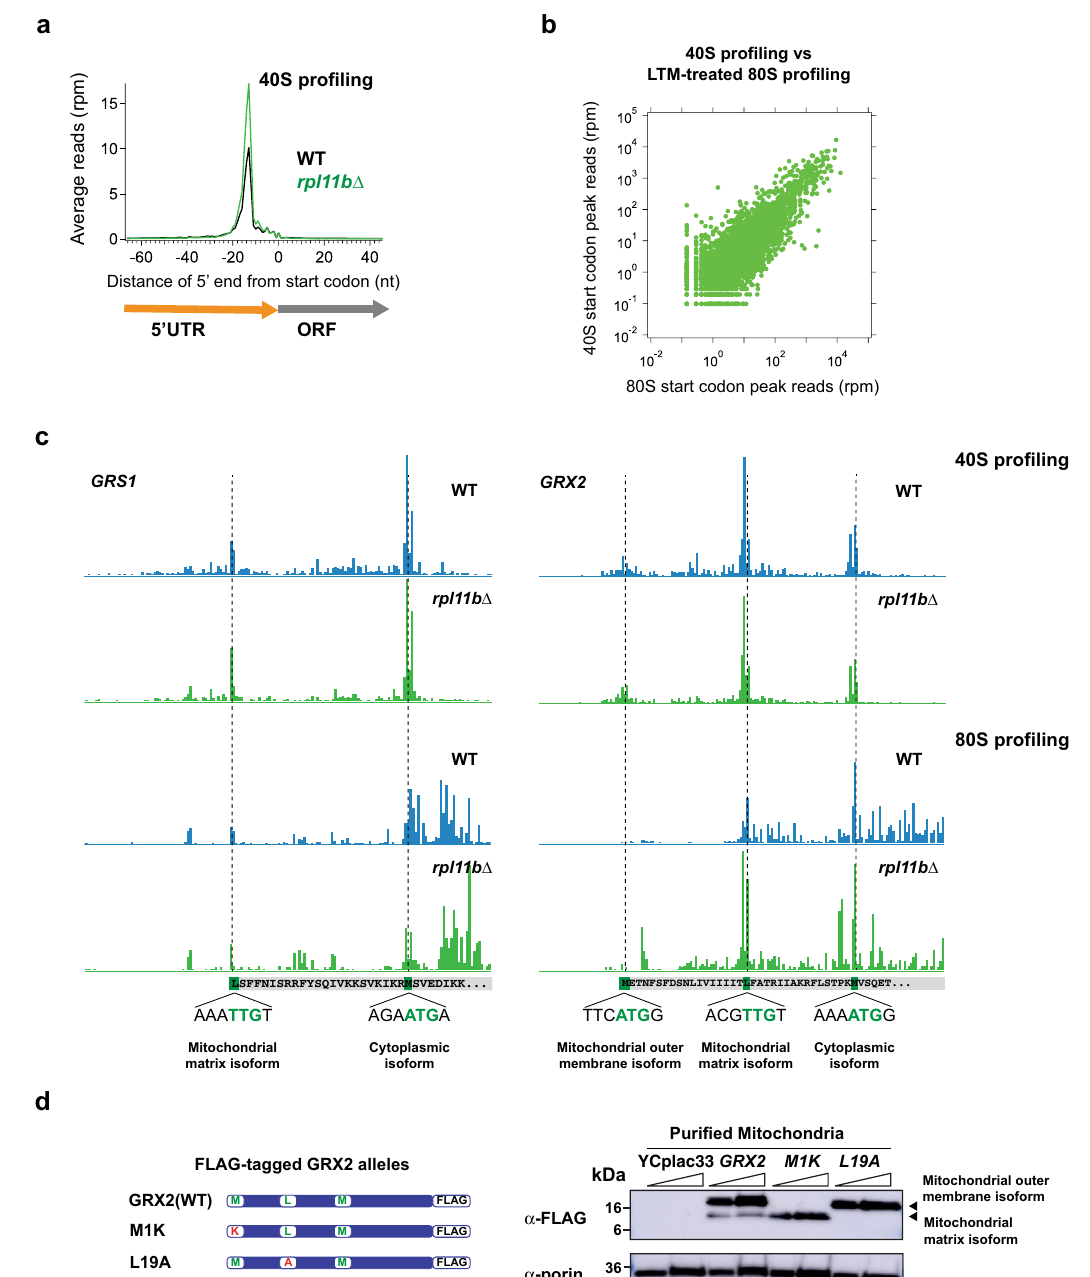
Fig. 2 40S PICs are enriched on start codons due to loss of RPL11B and predict downstream translation. a Average ribosome footprint occupancy at start codons increased (~2×) for 40S data for cells lacking RPL11B . Footprints of 26 – 45 nt plotted by 5 ′ ends. b Comparison of 40S start codon peak levels (total footprints at the start codon) with LTM-treated 80S start codon peak levels (total footprints at the start codon) from Eisenberg et al. (2020) 42 revealed a strong correlation (Pearson R 2 = 0.61) showing that 40S peaks can be used to identify translation start sites. Each point represents the data for one gene. Footprint reads were quantitated after shifting 40S data by 14 nt and 80S data by 13 nt. c Data from 40S and 80S pro fi ling data corresponding to the GRS1 and GRX2 genes. The 40S footprint occupancy peaks at cognate AUG and near-cognate UUG codons reveal the N-terminal extensions that are apparent in the 80S data. Gene annotations (DNA sequences and amino acids encoded by cognate tRNAs) are drawn to correspond to ribosome P sites. d Analysis of mitochondria that were puri fi ed from BY4741 cells expressing FLAG-tagged versions of either WT GRX2 , GRX2-M1K , or GRX2-L19A from the sc expression vector YCplac33. Diagrams of the FLAG-tagged GRX2 alleles showing the three potential translation start sites and their mutations are shown on the left. TCA protein extracts from the puri fi ed mitochondria were subjected to western analysis using mouse monoclonal antibodies against FLAG (top blot) or VDAC1/Porin (mitochondrial control, bottom blot). Two amounts of extracts (1× and 2×) were loaded in each lane pair. The M1K mutation results in loss of expression of the mitochondrial outer membrane Grx2 isoform and the L19A mutation results in loss of expression of the mitochondrial matrix Grx2 isoform. Westerns were repeated twice on two independently grown cultures for each condition to ensure replicability. nt nucleotide, rpm reads per million, kDa kilodalton. Source data are provided as a Source Data fi le. See also Supplementary Fig.